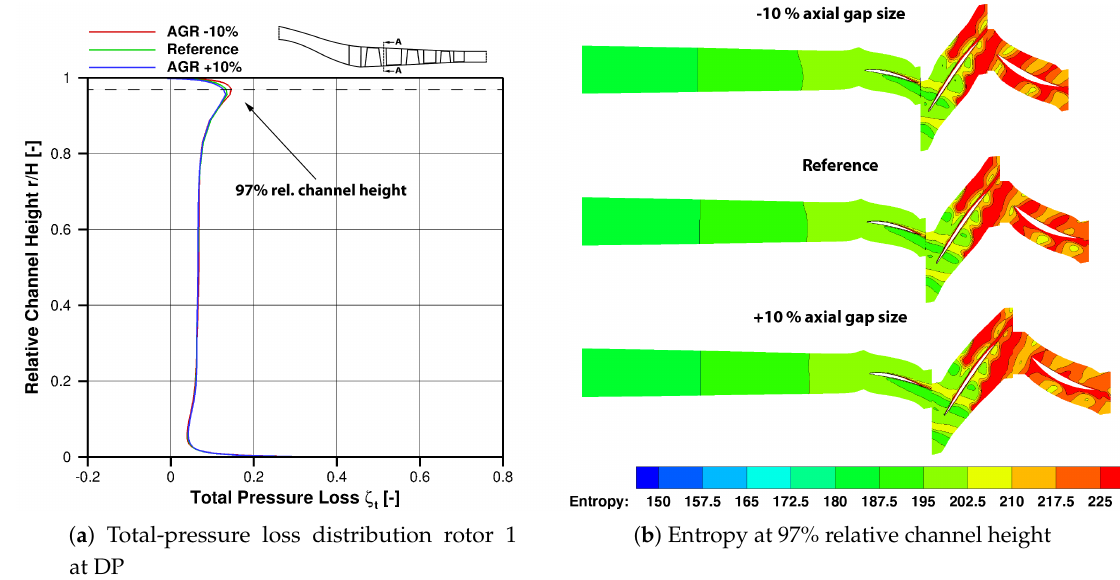
Figure 18. Effect of axial blade